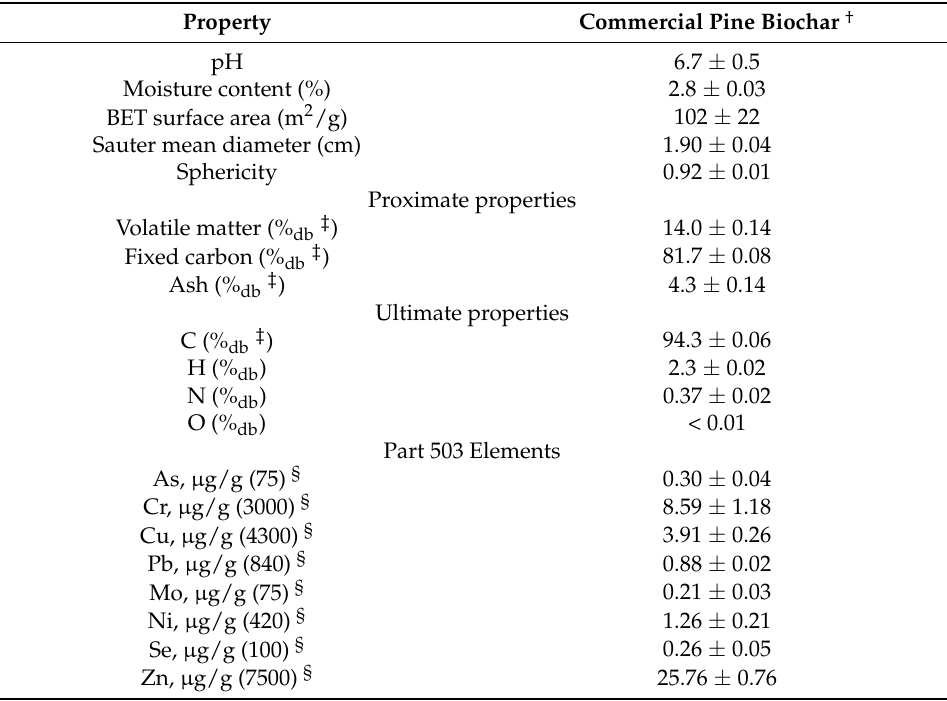
Table 1. Commercial pine biochar